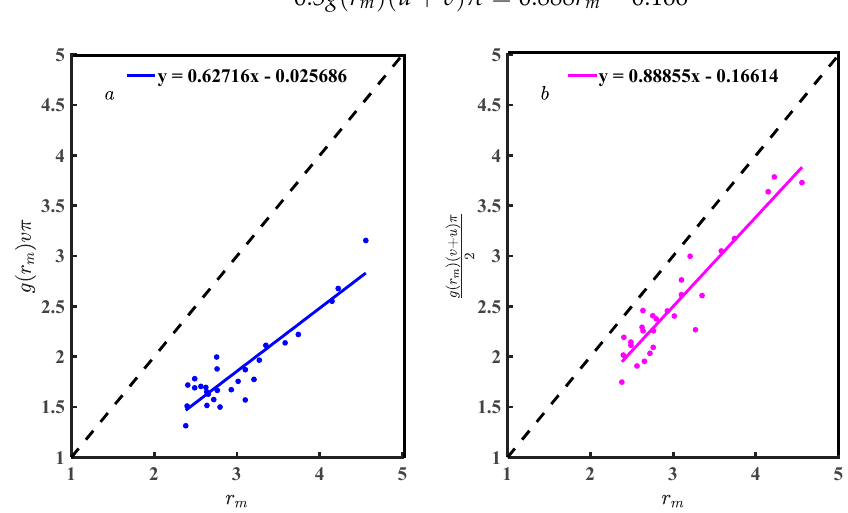
Figure 8. ( a ) Scatter diagram of Equation (18); and ( b ) scatter diagram of Equation (20).